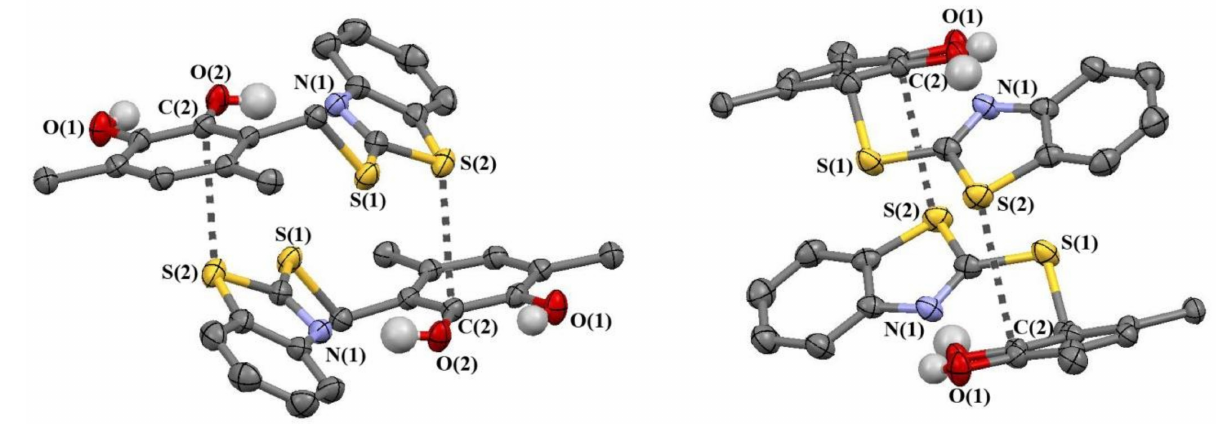
Figure 2. The views on the intermolecular S–C contacts between two neighboring molecules in the crystal of catechol 8 from two different angles. Hydrogen atoms (except hydroxyl) and methyl groups of tert -butyl substituents are